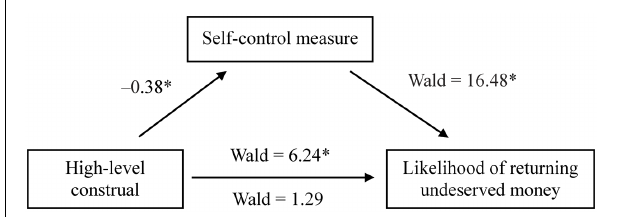
FIGURE 3 | Mediation of the effect of exposure to “why” questions (high-level construal) regarding morality on the likelihood of returning undeserved money (1 = return, 0 = no return) in Experiment 2. The number of the path between high-level construal and self-control measure is a standardized regression coefficient. The self-control measure was indexed as the mean difference in reaction time (ms) between incongruent and congruent trials in the Stroop task. Less Stroop interference indicates a state of greater self-control. On the lower path, the values of Ward statistics below and above the arrow are the results of analyses in which the mediator was and was not included in the model, respectively. Asterisks indicate significant results ( p < 0.05).